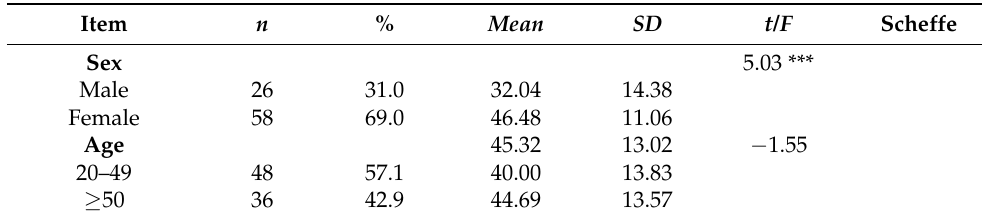
Table 1. Analysis of basic attributes and post-traumatic growth of major family caregivers of liver transplantation (n =